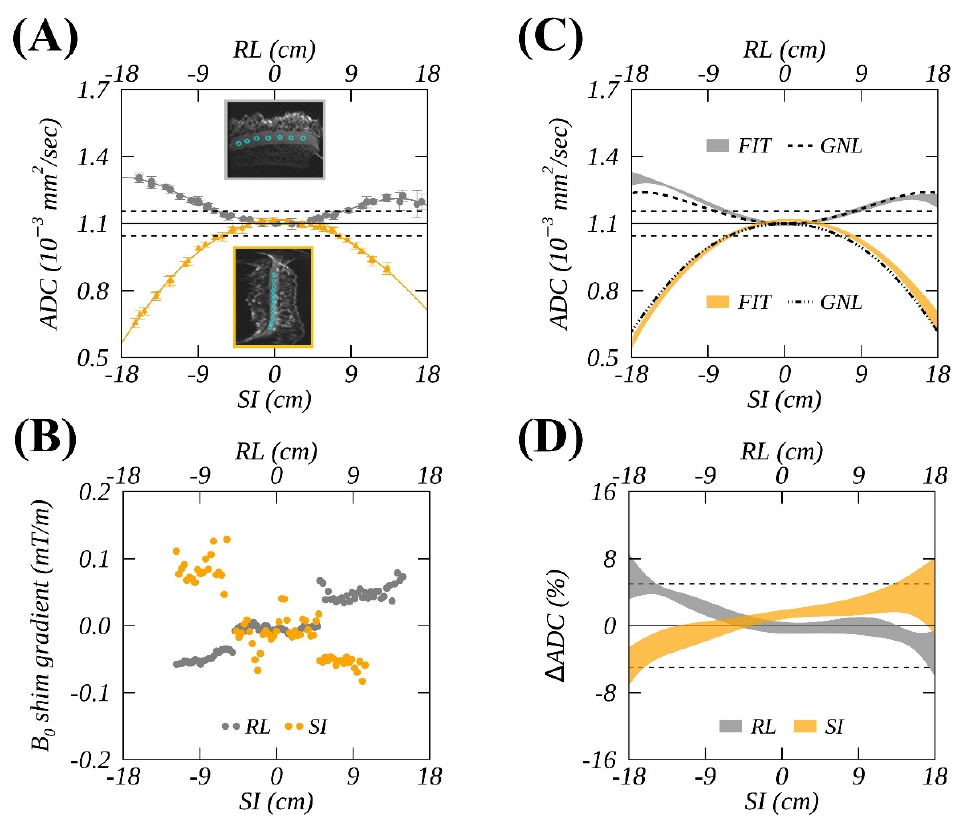
Figure 1. An example of ice-water spatial-dependent (i.e., right-left (RL) offsets in gray and superior-inferior (SI) offsets in orange) apparent diffusion coefficient (ADCs) measured for the G y gradient channel ( A ) and B 0 shim gradients ( B ) on a 1.5T MR scanner. Fitted ADCs (ribbons corresponding to temporal mean ± SD) from longitudinal studies were compared with a predicted (dashed curves) system-specific gradient nonlinearity (GNL) model in ( C ), and their relative differences normalized by an ADC reference (solid horizonal line) of 1.1 × 10 − 3 (mm 2 /s) are shown in ( D ). Mean ADC measurements within regions of interest (ROIs) (e.g., cyan circles in A-inset) are plotted as a function of RL and SI offsets, respectively, with error-bars corresponding to a standard deviation within an ROI. Dashed horizontal lines denote ± 5% deviations from the reference ice ‐ water ADC value.